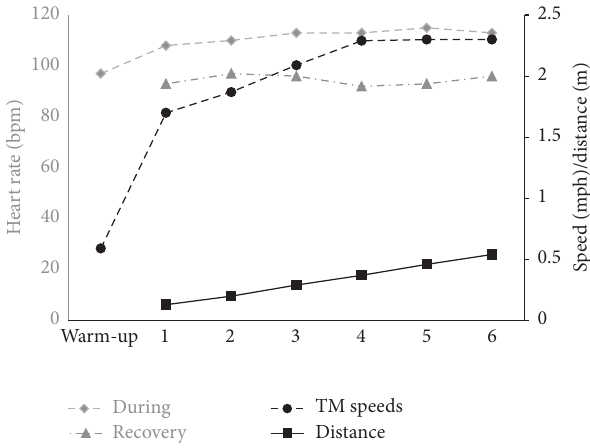
Figure 1: Representative example from one participant (number 2) during HIITT showing heart rate during training (gray dia- monds),heartrateduringrecovery(graytriangles),treadmillspeeds achieved at each interval (black circles), and composite distance (black squares). Heart rate (beats per minute) is represented on the primary left 𝑦 -axis. Speed (miles per hour) and distance (miles) are presented on the secondary right 𝑦 -axis. 𝑥 -axis represents the time scale during treadmill training: 5 minute warm-up, the six walking intervals that the participant achieved during the session or in the case of the recovery HR, and the six recovery intervals that the participant needed to restore the HR to